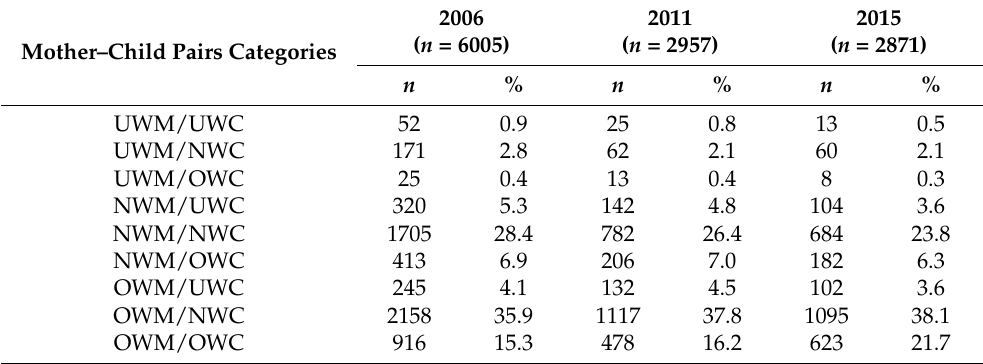
Table 3. Prevalence of mother–child pairs by BMI categories for years 2006, 2011 and 2015.